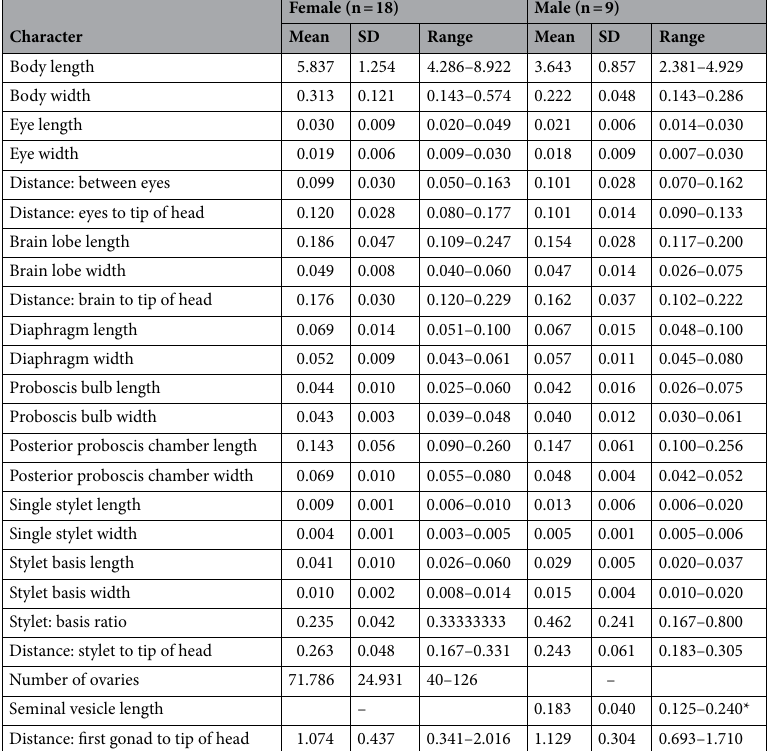
Table 3. Measurements of Carcinonertes camanchaco sp. nov. All measurements are given in mm (exceptions include: Stylet: basis ratio, and the number of ovaries [direct count]). SD standard deviation, *Two specimens